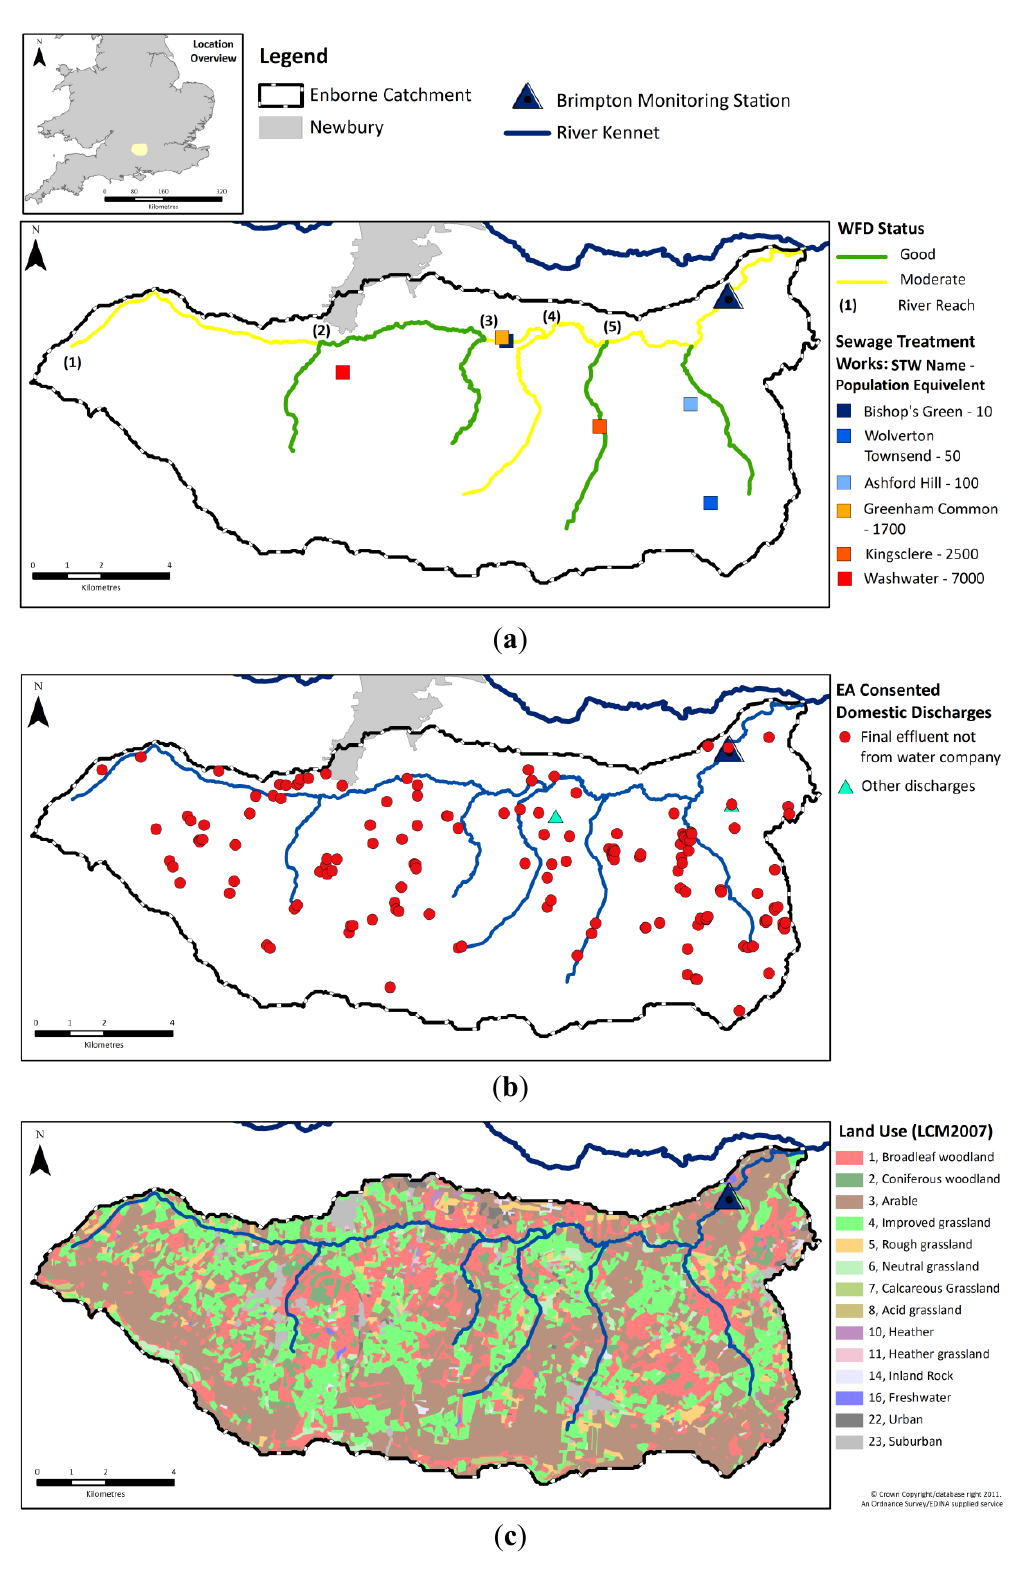
Figure 1. The Enborne catchment: ( a ) The Water Framework Directive (WFD) river designations and the sewage treatment work (STW) locations; ( b ) other registered consented domestic discharge locations; ( c ) Land use (from Land Cover Map 2007